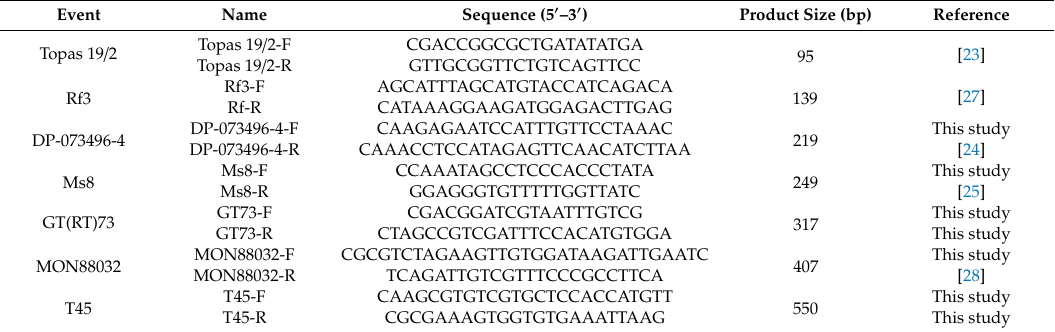
Table 1. Newly designed oligonucleotide primers used to detect the seven living modified canola